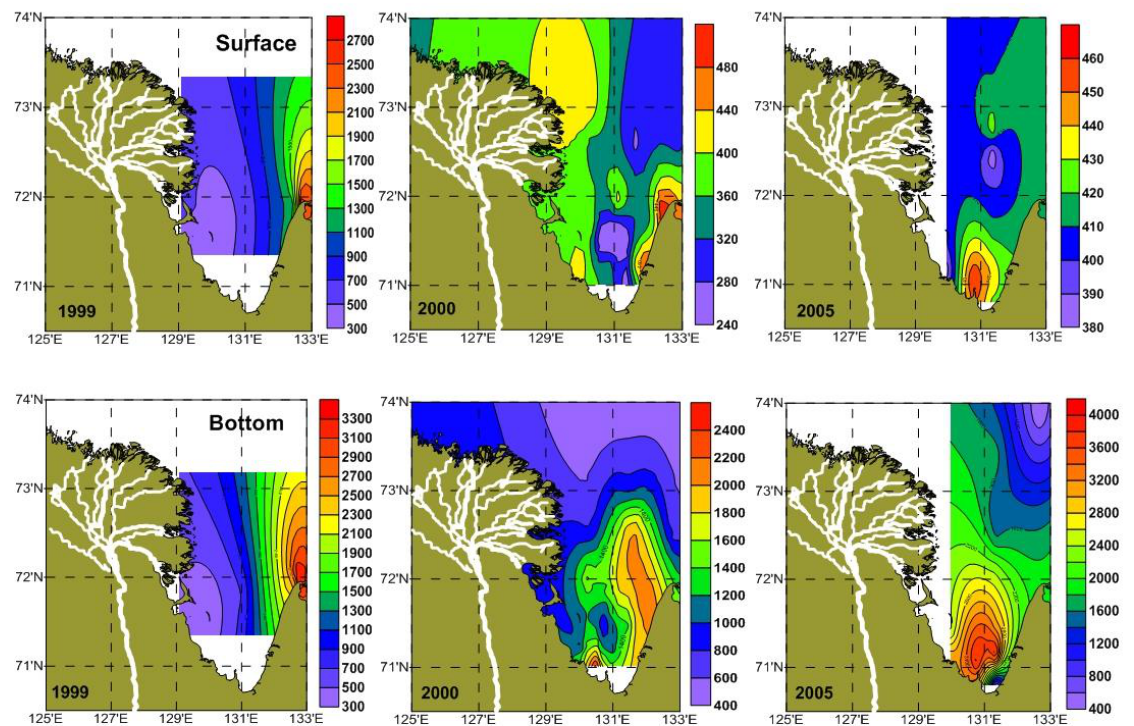
Fig. 15. Distribution of CO 2 partial pressure ( p CO 2 , µatm) in the surface and bottom water layers of the Buor-Khaya Bay observed in 1999, 2000 and